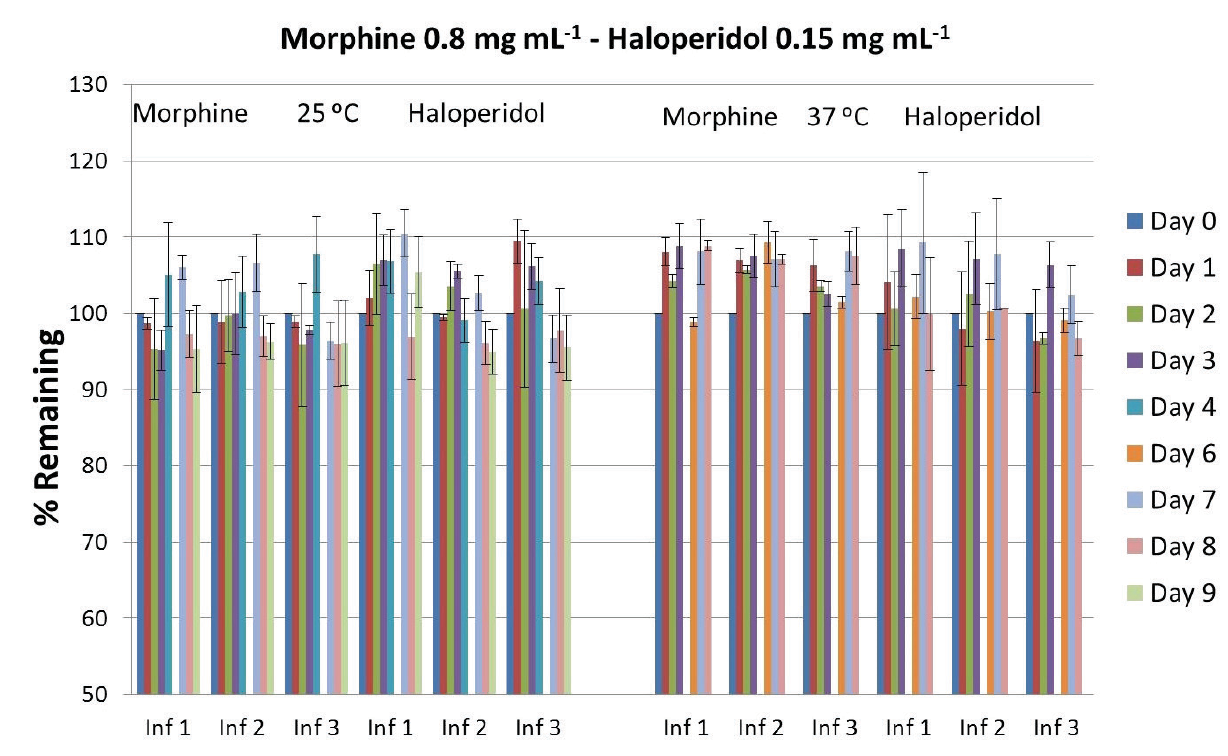
FIGURE 2 - Percentages of mixtures remaining at 25 ºC and 37 ºC.